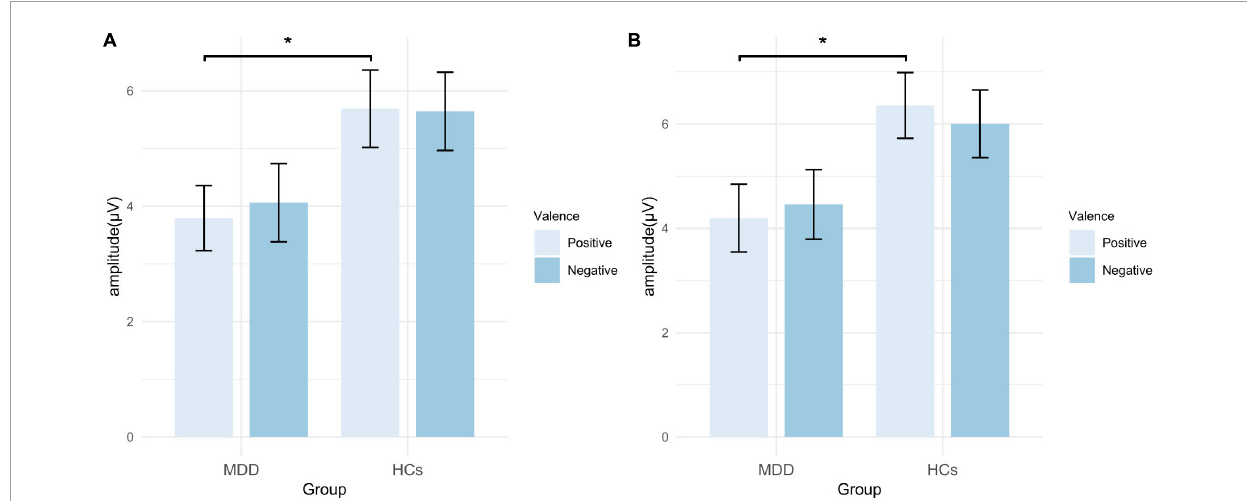
FIGURE8 Mean amplitude of LPP in EAST. (A) Amplitudes of self-words; (B) amplitudes of other-words. MDD, major depressive disorder; HCs, healthy controls; EAST, External Affect Simon Task; error bars represent the standard error. * p <